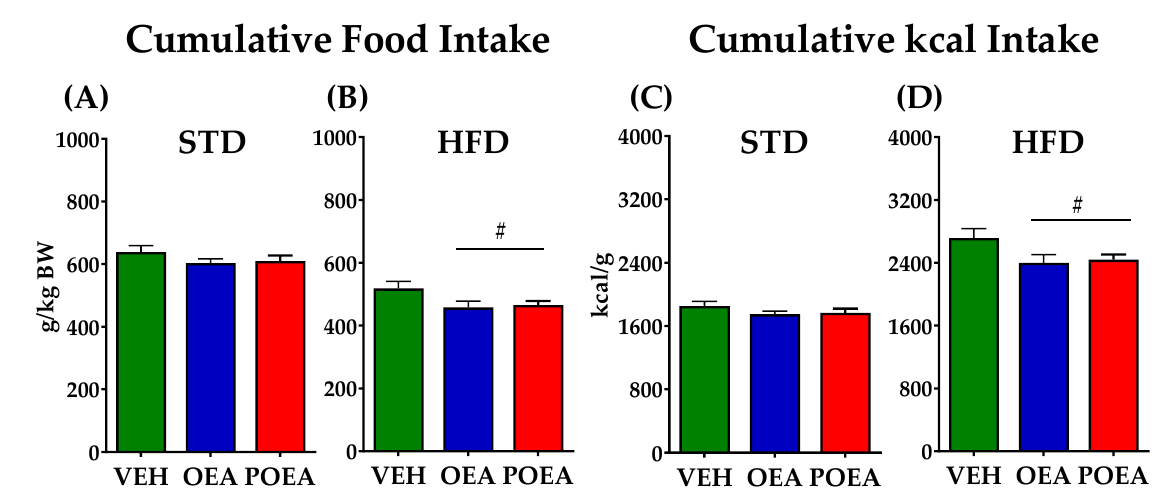
Figure 5. Effects of sub-chronic (15 days) administration of a 10 mg/kg dose of either oleoylethanolamide (OEA) or palmitoleylethanolamide (POEA) on food intake, which was measured as g/kg body weight ( A , B ) or cumulative kcal ( C , D ). Points or bars are means ± standard error of the mean (SEM) ( n = 8 animals per group). Unpaired t -test: (#) p < 0.05 vs. vehicle (VEH) group.